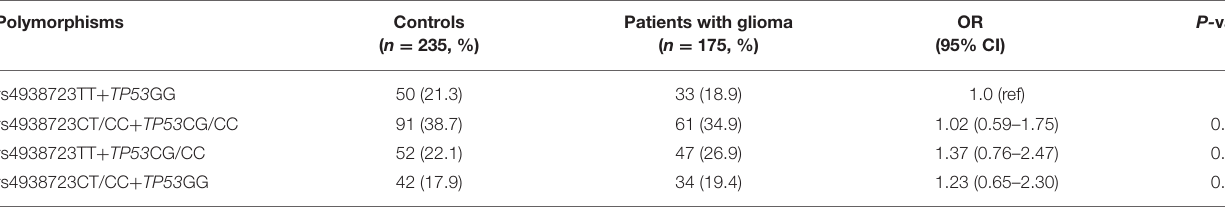
TABLE 4 | Combined effect of miR-34b/c rs4938723 and TP-53 Arg72Proon glioma risk. Polymorphisms Controls ( n = 235,